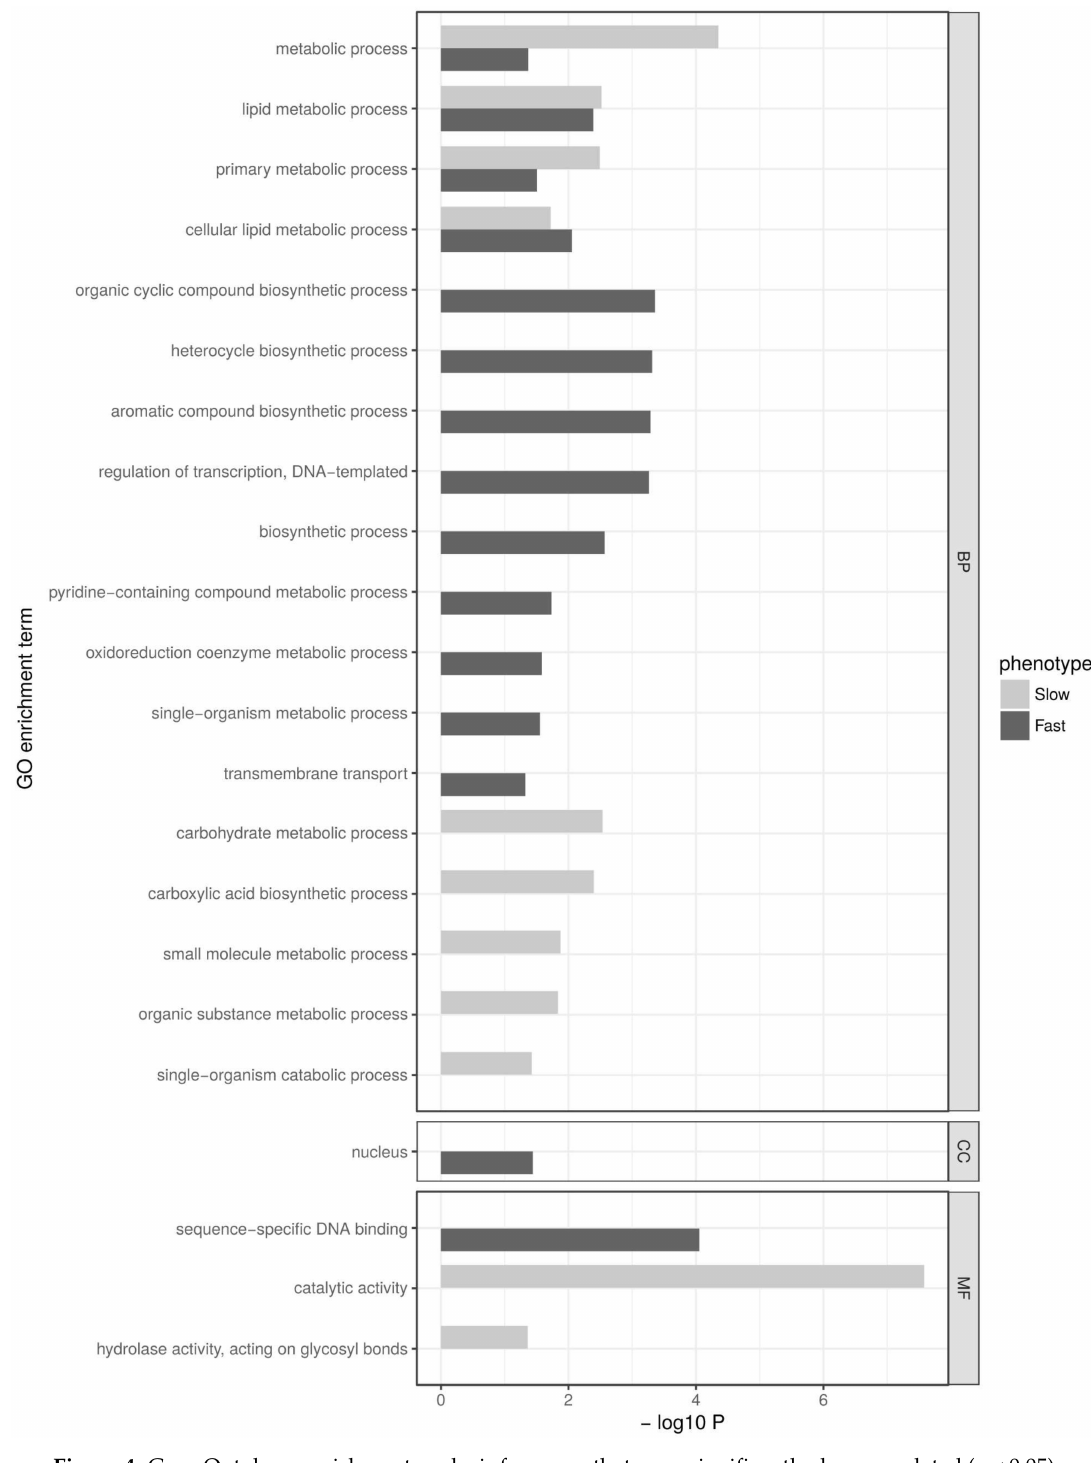
Figure 4. Gene Ontology enrichment analysis for genes that were significantly downregulated ( p < 0.05) at 90 min after the cold shock in cold-sensitive fly strains (slow CCR, light bars) and cold-tolerant fly strains (fast CCR, dark bars). Gene Ontology terms are plotted according to the significance of their enrichment ( − log10 p -value after Benjamini–Hochberg correction). Terms in three different categories are shown: biological process (BP), cellular component (CC) and molecular function